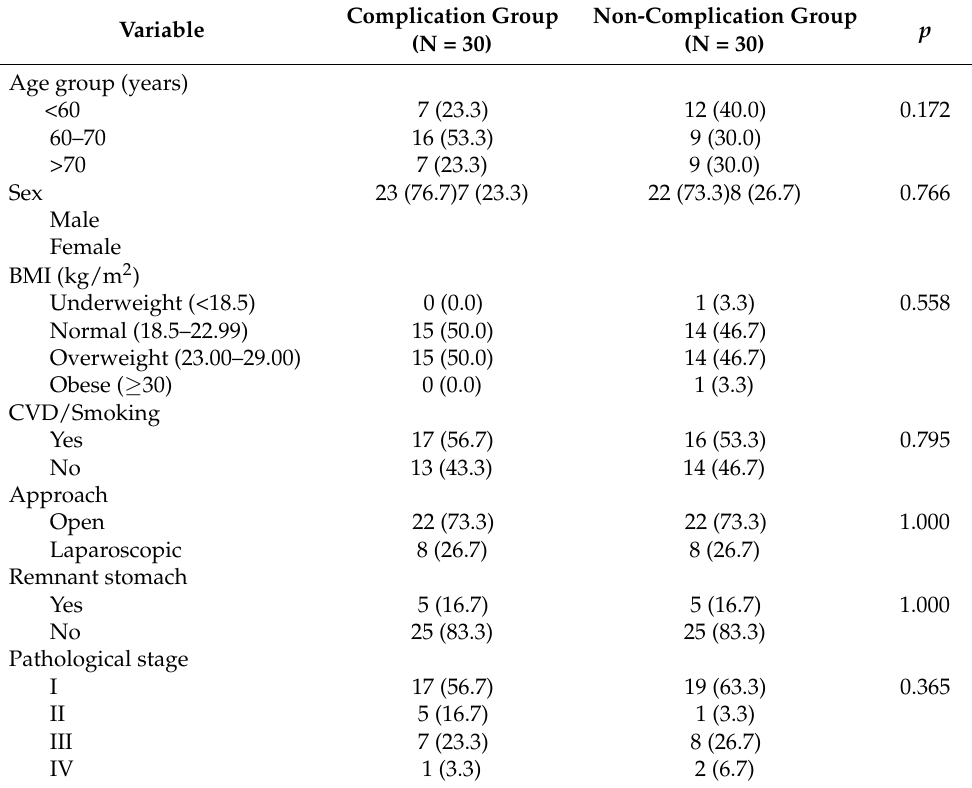
Table 2. Comparison of baseline characteristics between complication and non-complication groups after propensity score